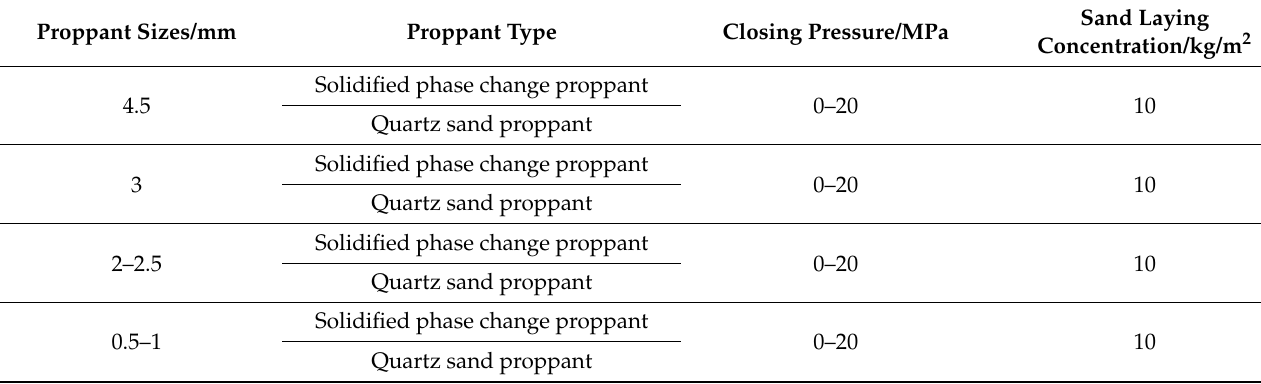
Figure 13. Morphology of rock slab. Table 3. Experimental scheme of diversion